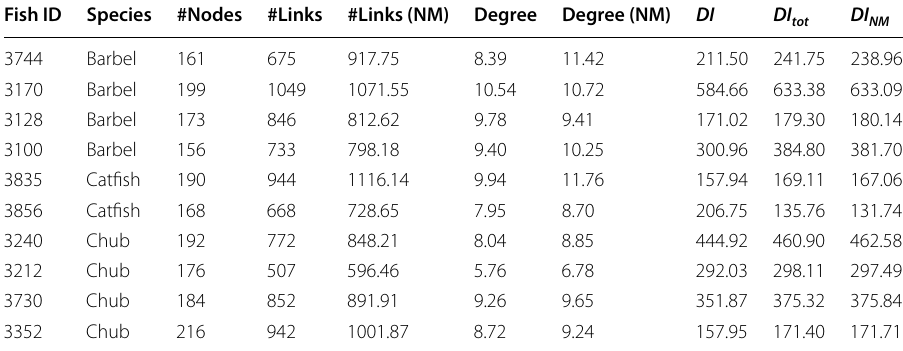
Table 1 Statistical properties of the resting event networks